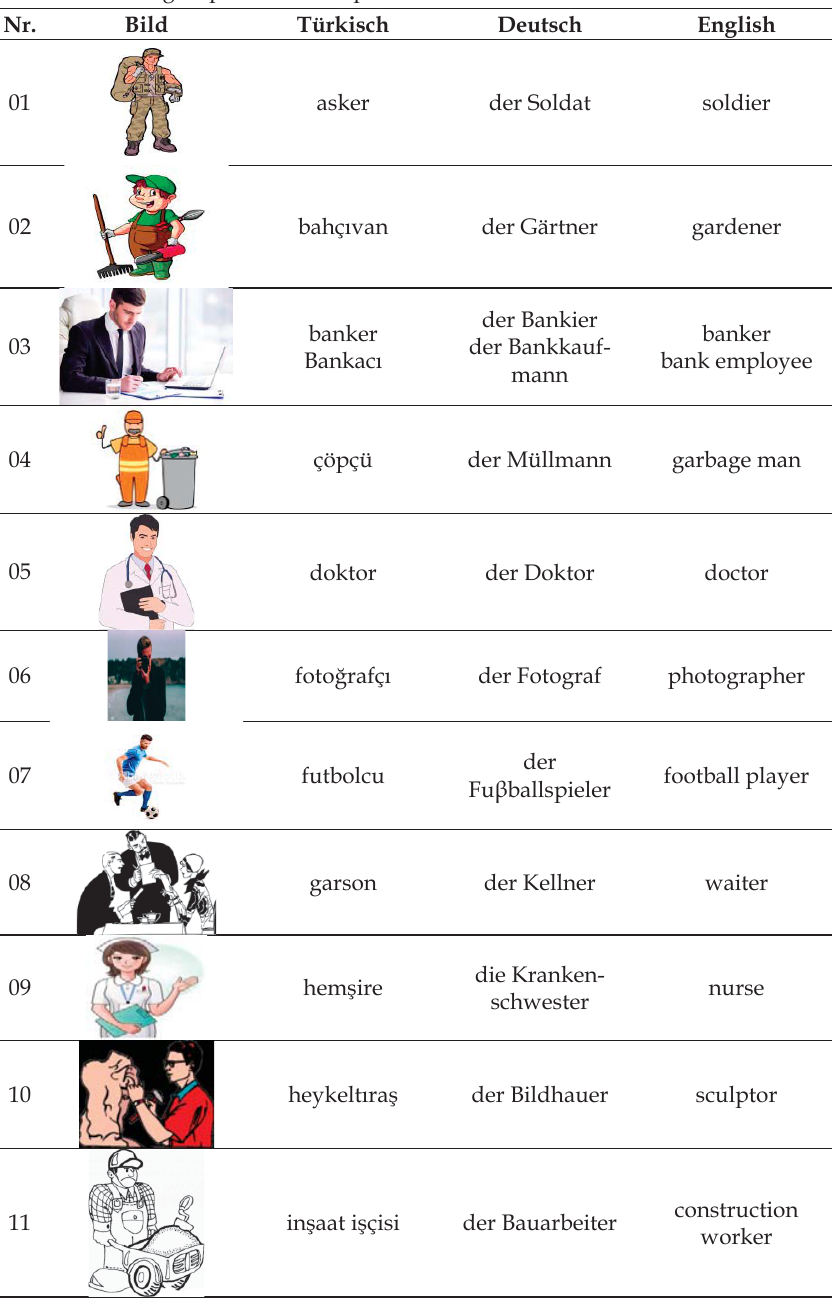
Table 2. (cid:3)(cid:55)(cid:75)(cid:72)(cid:3)(cid:192)(cid:85)(cid:86)(cid:87)(cid:3)(cid:74)(cid:85)(cid:82)(cid:88)(cid:83)(cid:3)(cid:82)(cid:73)(cid:3)(cid:90)(cid:82)(cid:85)(cid:71)(cid:86)(cid:3)(cid:73)(cid:82)(cid:85)(cid:3)(cid:83)(cid:85)(cid:82)(cid:73)(cid:72)(cid:86)(cid:86)(cid:76)(cid:82)(cid:81)(cid:86)(cid:17) Nr.